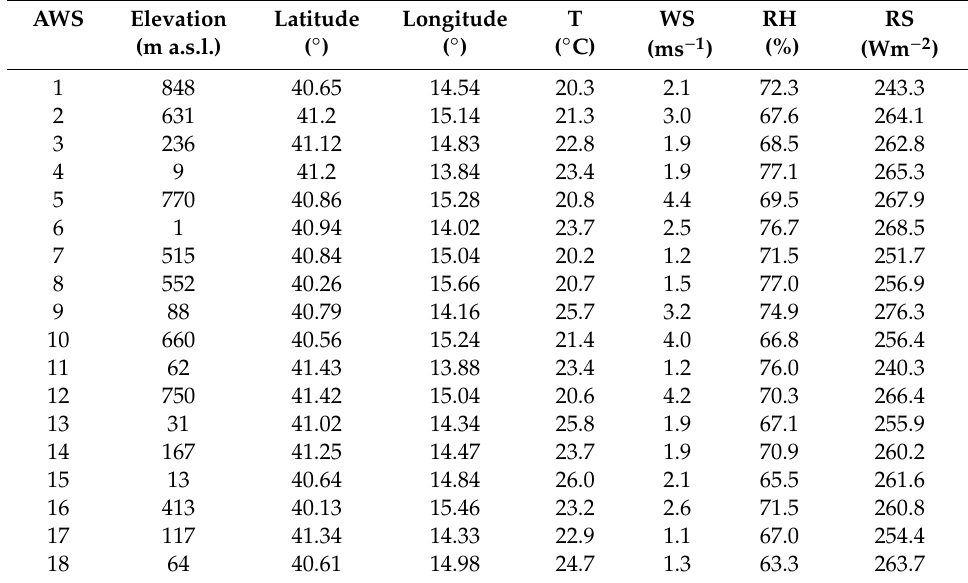
Table 1. List of the available Automatic Weather Stations (AWSs) with the average measured weather values in the period